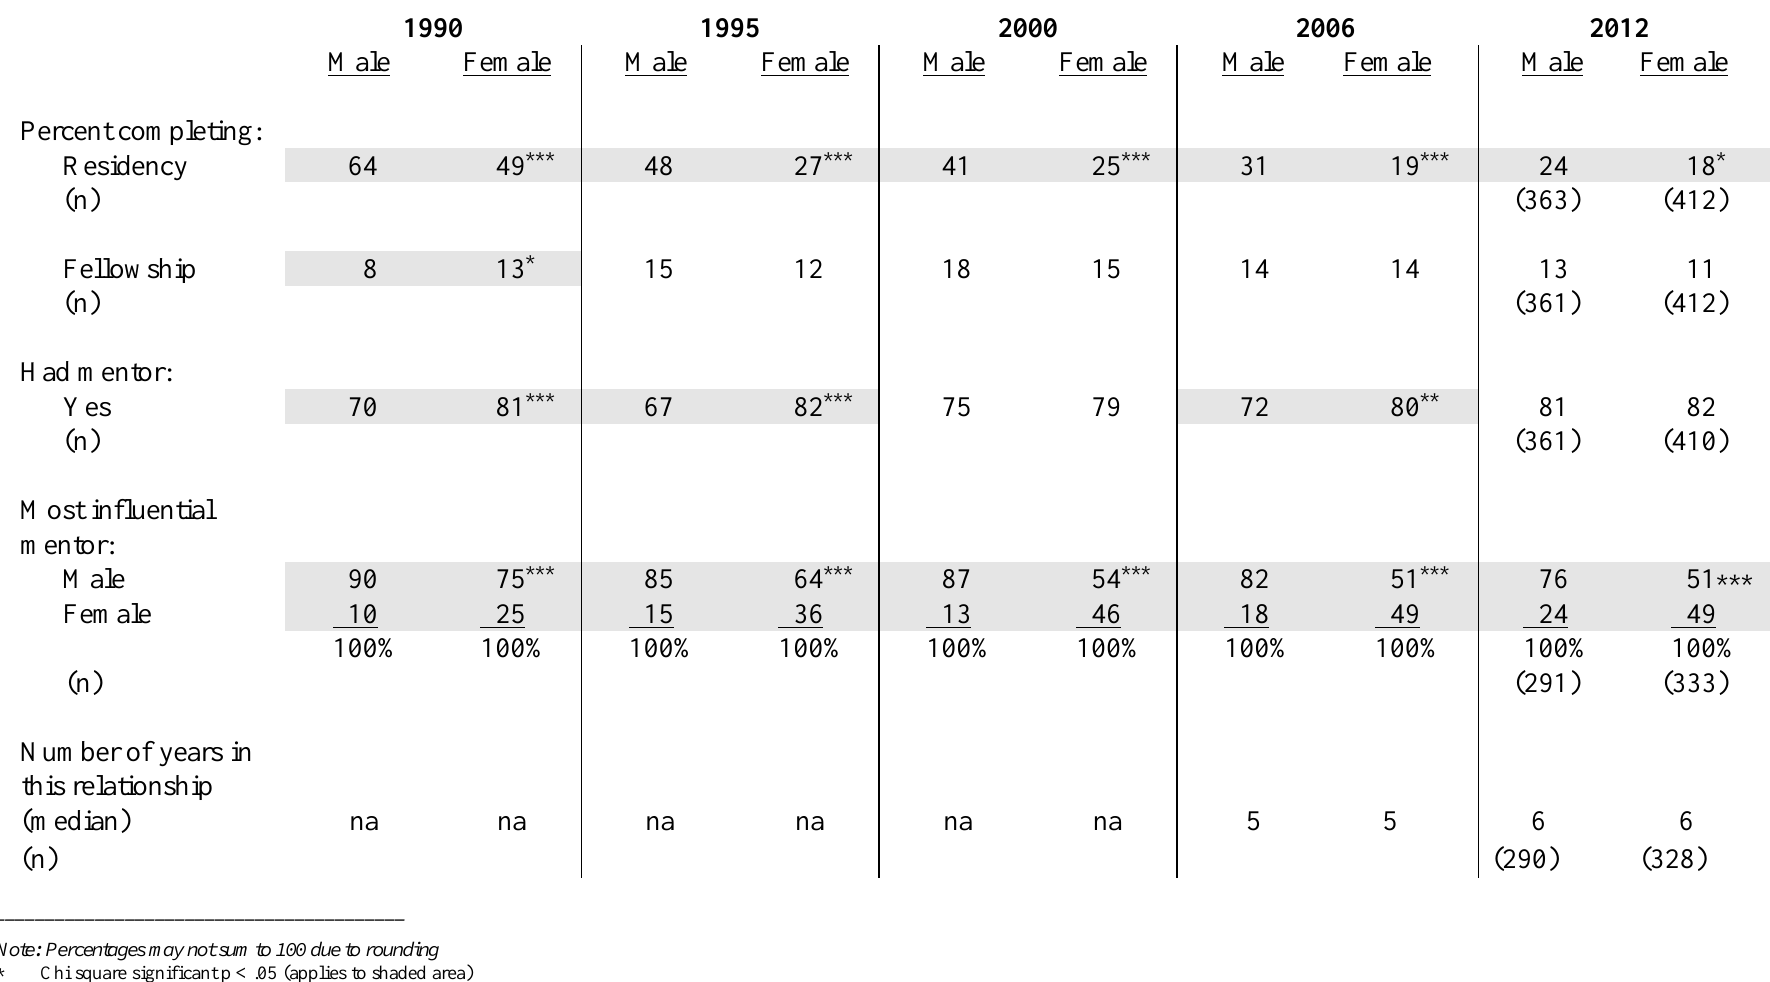
Table 13. Residency, Fellowship and Experience With Mentors